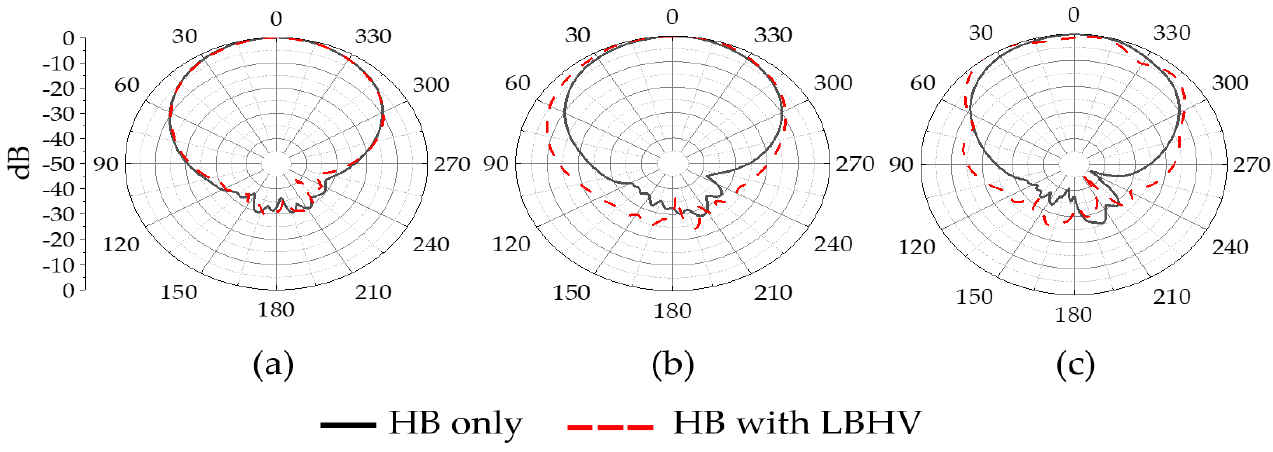
Figure 3. High-band measured azimuth radiation patterns with a LBHV element at ( a ) 1.8 GHz, ( b ) 2.4 GHz, and ( c ) 2.6 GHz.